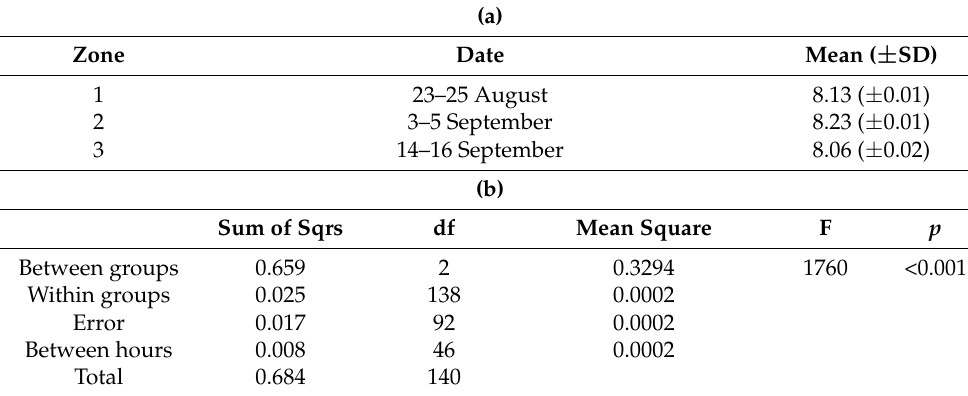
Table 2. (a) Mean ( ± SD) values of pH measured in the three zones of the cave. (b) Results of analysis of variance (ANOVA) on the pH repeated measures in the three zones of the